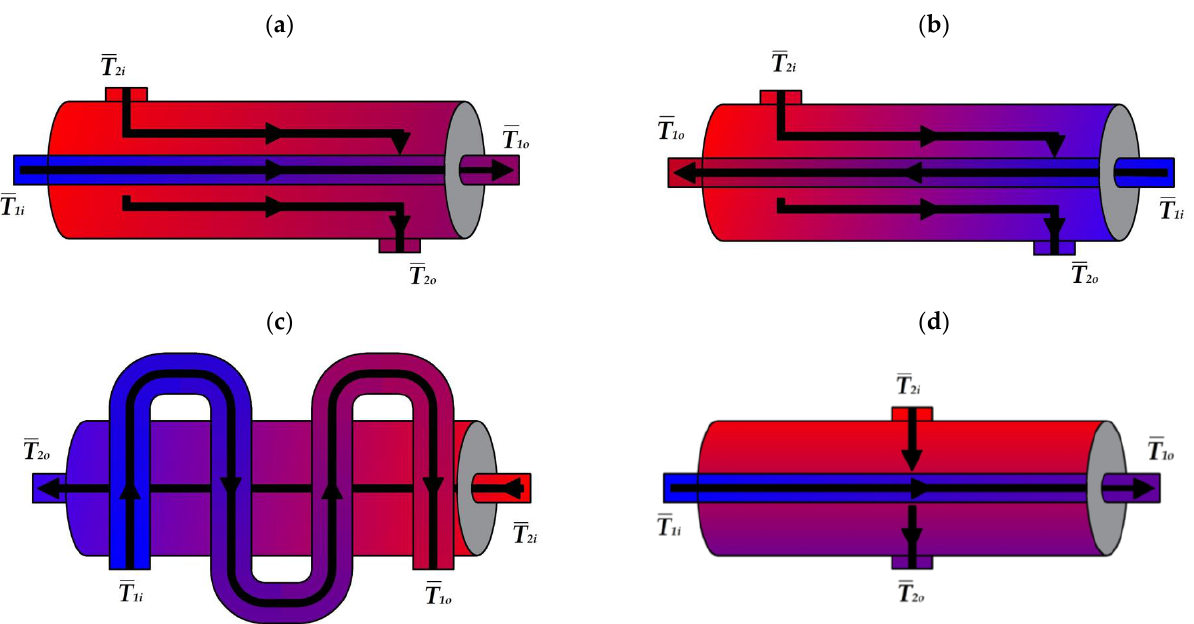
Figure 3. Heat exchanger fluid flow classification: ( a ) co-current flow, ( b ) countercurrent flow, ( c ) hybrid flow, ( d ) crossflow; T 1 i —temperature of the first medium at the inlet to the heat exchanger, T 1 o —temperature of the first medium at the outlet of the heat exchanger, T 2 i —temperature of the second medium at the inlet to the heat exchanger, T 2 o —temperature of the second medium at